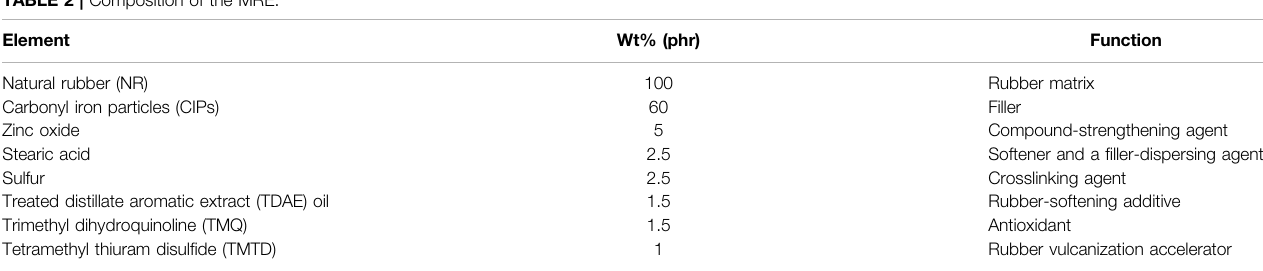
TABLE 2 | Composition of the MRE. Element Natural rubber